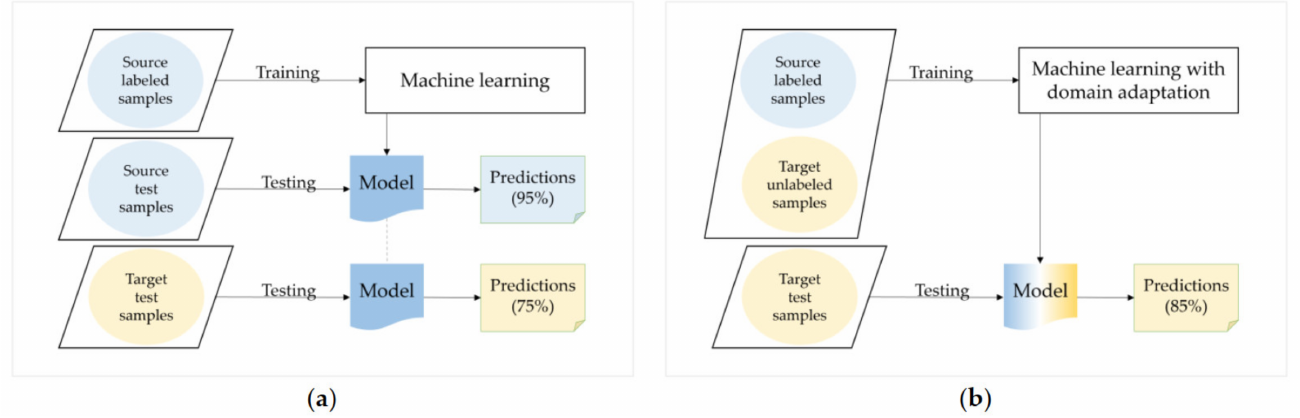
Figure 2. The underlying idea of domain adaptation: ( a ) a model that performs well in the source domain but worse when tested in the target domain (e.g., a decline in accuracy from 95% to 75%); ( b ) domain adaptation attempts to train a satisfactory model for the target domain by adding unla- beled target samples to the process (e.g., an improvement in accuracy from 75% to